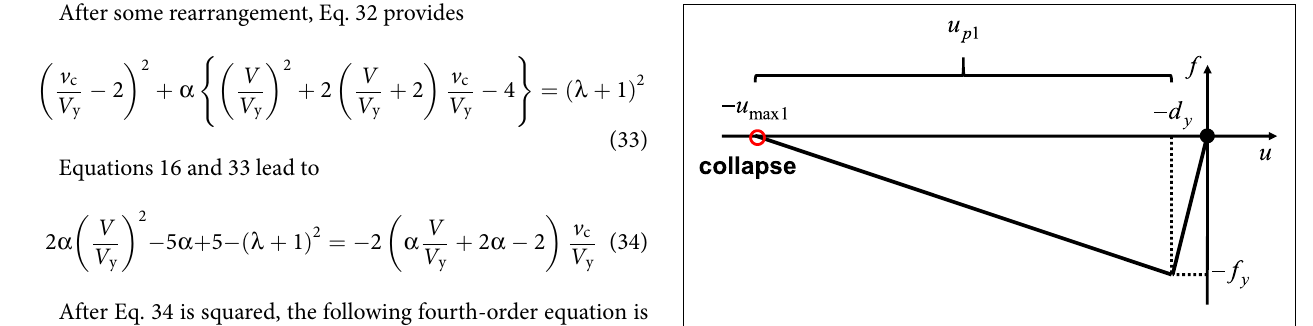
FIGURE 9 | Additional Pattern 1: limit after the first impulse